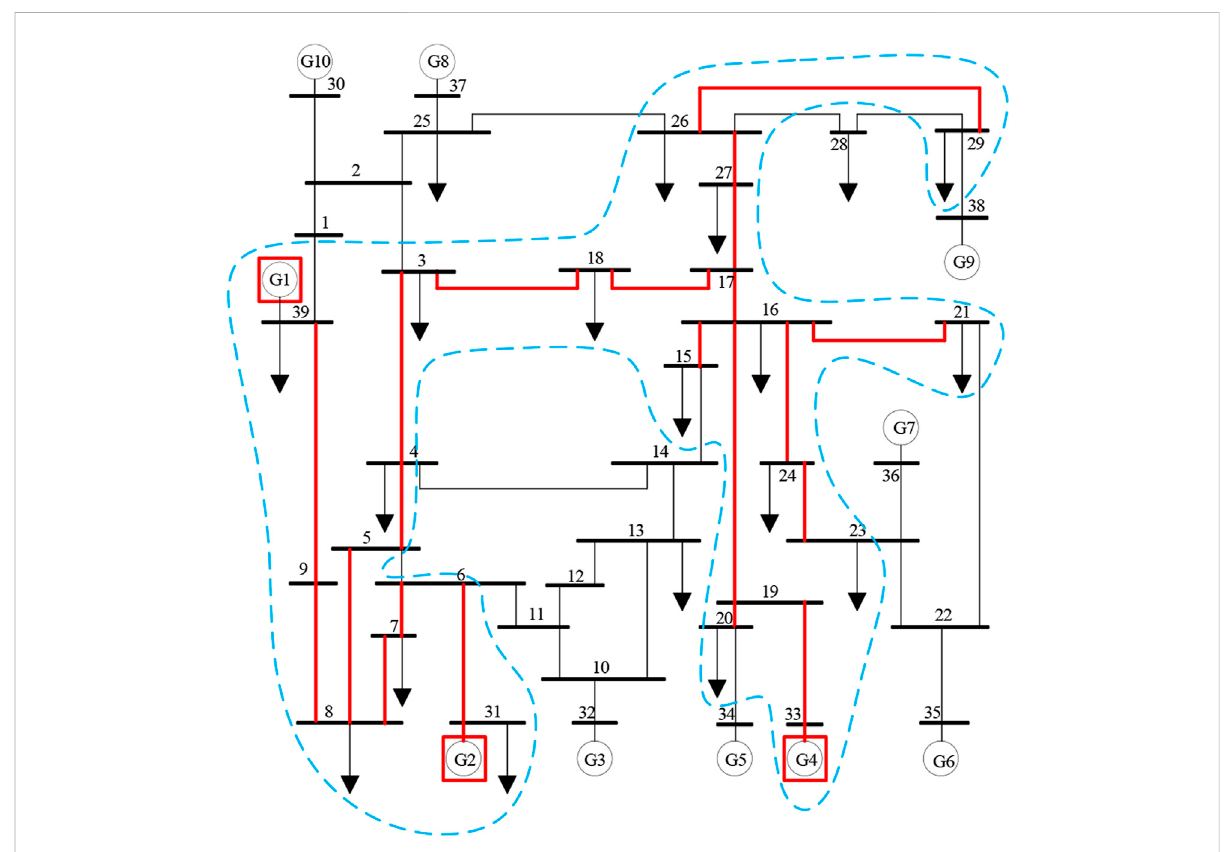
FIGURE 2 IEEE 39-bus system backbone grid considering connectivity